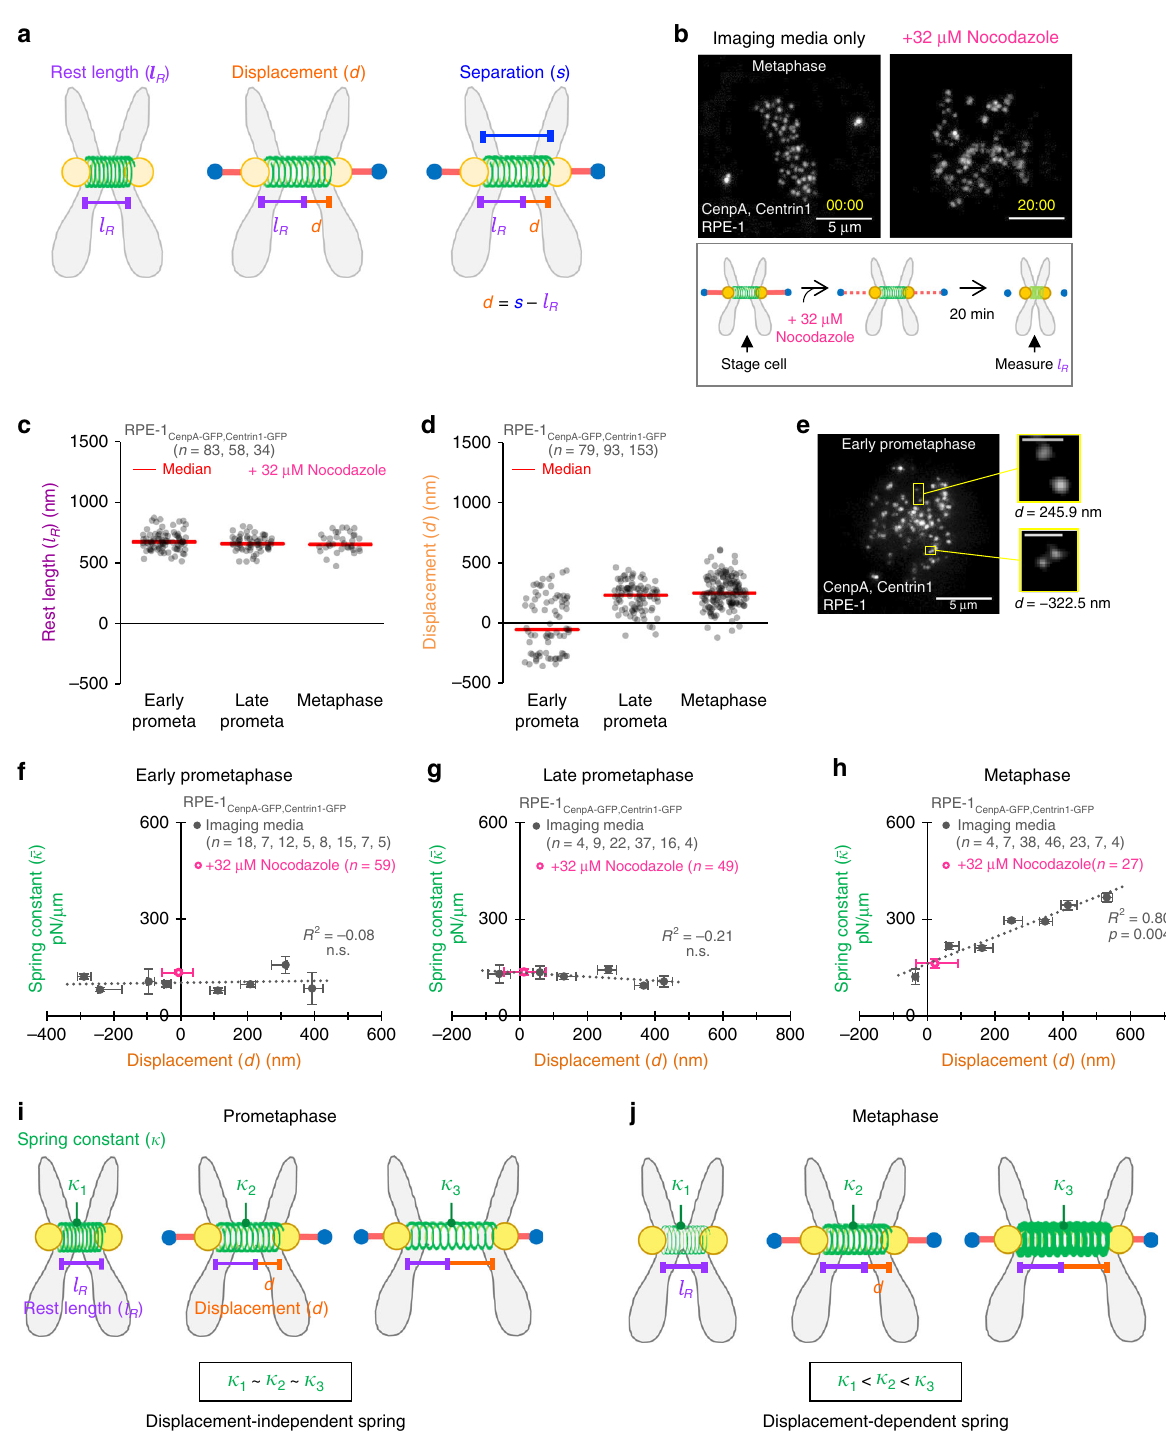
(Fig. 5b, shaded area) for a metaphase chromosome (Fig. 5b, solid line) as compared to a late-prometaphase chromosome (Fig. 5b, dotted line), from a total range in magnitudes of 67.6 pN at late- prometaphase to 237 pN at metaphase (Fig.